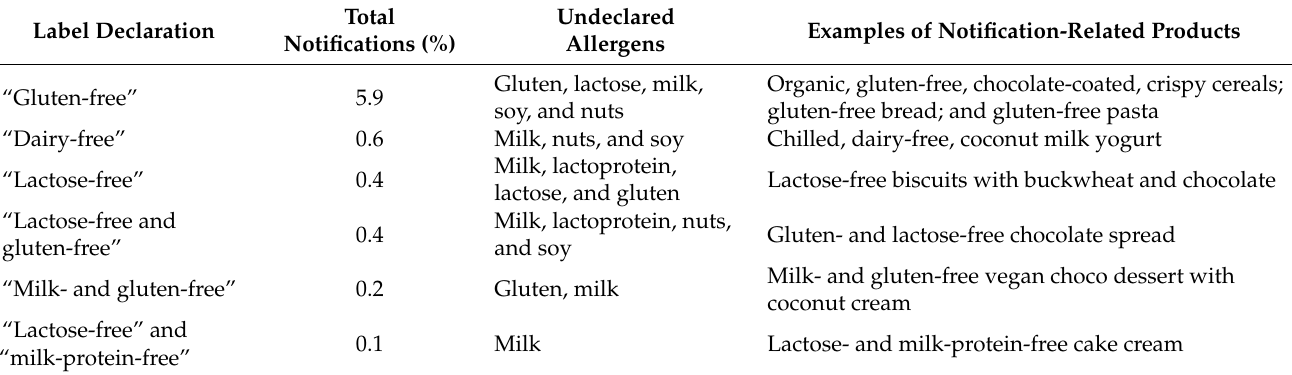
Table 3. Percentage of notifications which included specially designed products (gluten-free, lactose- free, dairy-free, etc.) and undeclared allergens involved in each case between 1 January 2018